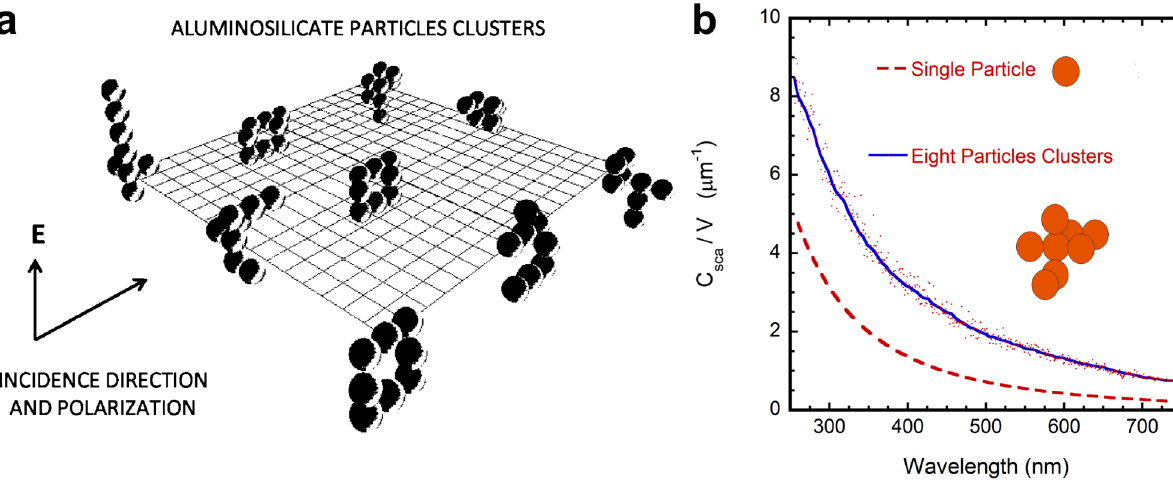
Figure 4. Aluminosilicate particles clusters and the average volumetric scattering cross section per particle. ( a ) Nine clusters generated by a diffusion limited aggregation scheme to evaluate the scattering cross section per unit volume and per particle corresponding to each cluster. Each cluster consists of 8 aluminosilicate particles with an average diameter of 184 nm. ( b ) Average volumetric scattering cross section of an aluminosilicate spherical particle in an 8-particle cluster. The average diameter of the particles is 184 nm, and a log normal size distribution was considered (single particle diameters between 130 and 240 nm). The orange dashed line corresponds to the isolated single particle, and the blue solid line is obtained from averaging the calculations at each wavelength (dots) carried out for the nine clusters displayed in figure 4a.